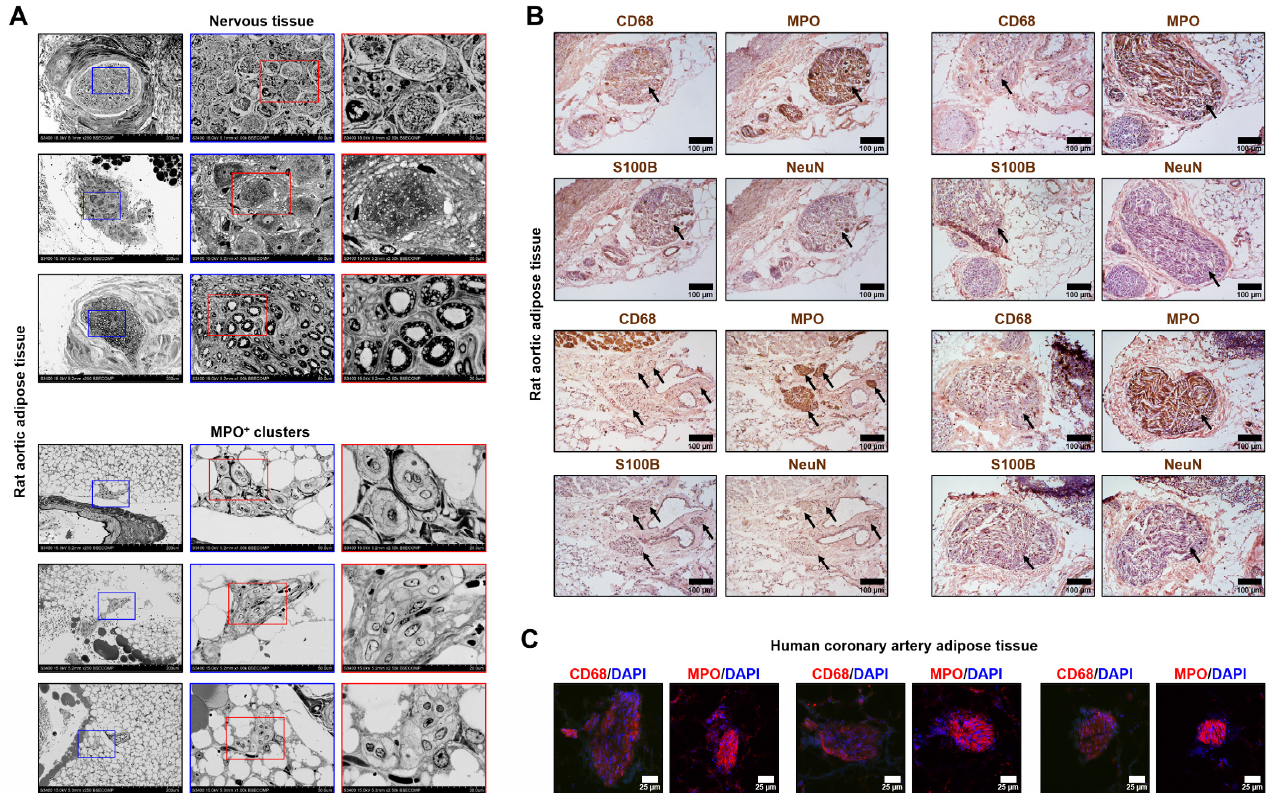
Figure 2. Ultrastructural examination of MPO + clusters and nerve bundles. ( A ) Backscattered scanning electron microscopy examination of the different types of nerve bundles (top) and MPO + clusters (bottom). Rat aortic adipose tissue. Red and blue contours demarcate × 1000 and × 2500 close-ups, respectively. × 250, × 1000, and × 2500 magnification (scale bars: 200 µ m, 50 µ m, and 20 µ m, respectively; accelerating voltage: 15 kV); ( B ) Immunohistochemical staining of MPO + clus- ters (indicated by black arrows) for a macrophage marker CD68, myeloid cell marker myeloper- oxidase, and neural tissue markers S100B and NeuN. Rat aortic adipose tissue. Note that MPO + clusters are positively stained for myeloperoxidase and CD68 while being negatively stained for S100B and NeuN. × 200 magnification (scale bar: 100 µ m); and ( C ) Immunofluorescence anti-CD68 and anti-MPO staining of the human coronary artery adipose tissue. Note the positive red stain- ing within the MPO + clusters and negative staining around them. DAPI nuclear